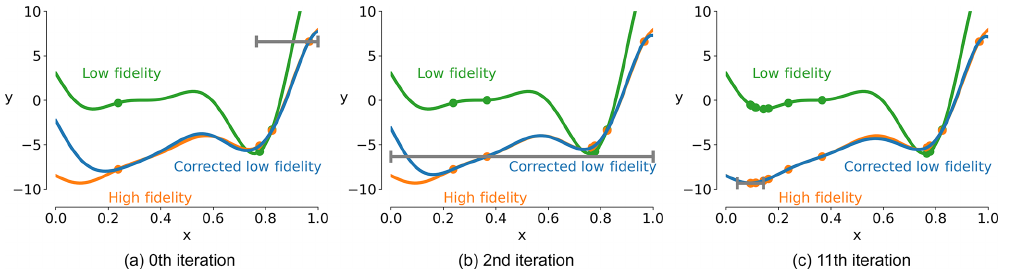
Figure 2. Trust-region optimization progression in the 1D example. In the 0th iteration (a) , the initial trust region does not contain the entire design space. In the 2nd iteration (b) , the trust region has grown as the local optimizer found the best answer at the bounds of the trust region. In the 11th iteration (c) , the trust region narrows around the local minima.